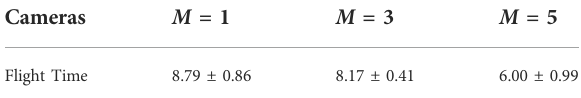
Table 8 — M = 3 is a more appropriate design choice for this use-case. The fi nal drone design is shown in Figure 9.